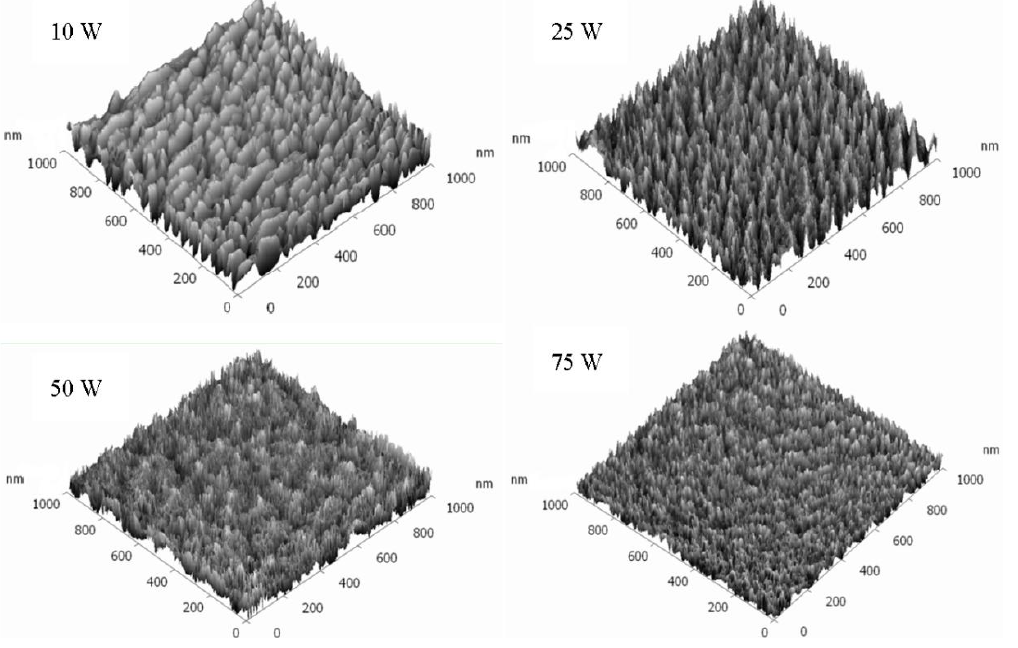
Figure 5. AFM images of pp–GT thin films fabricated at 10, 25, 50, and 75 W input RF power